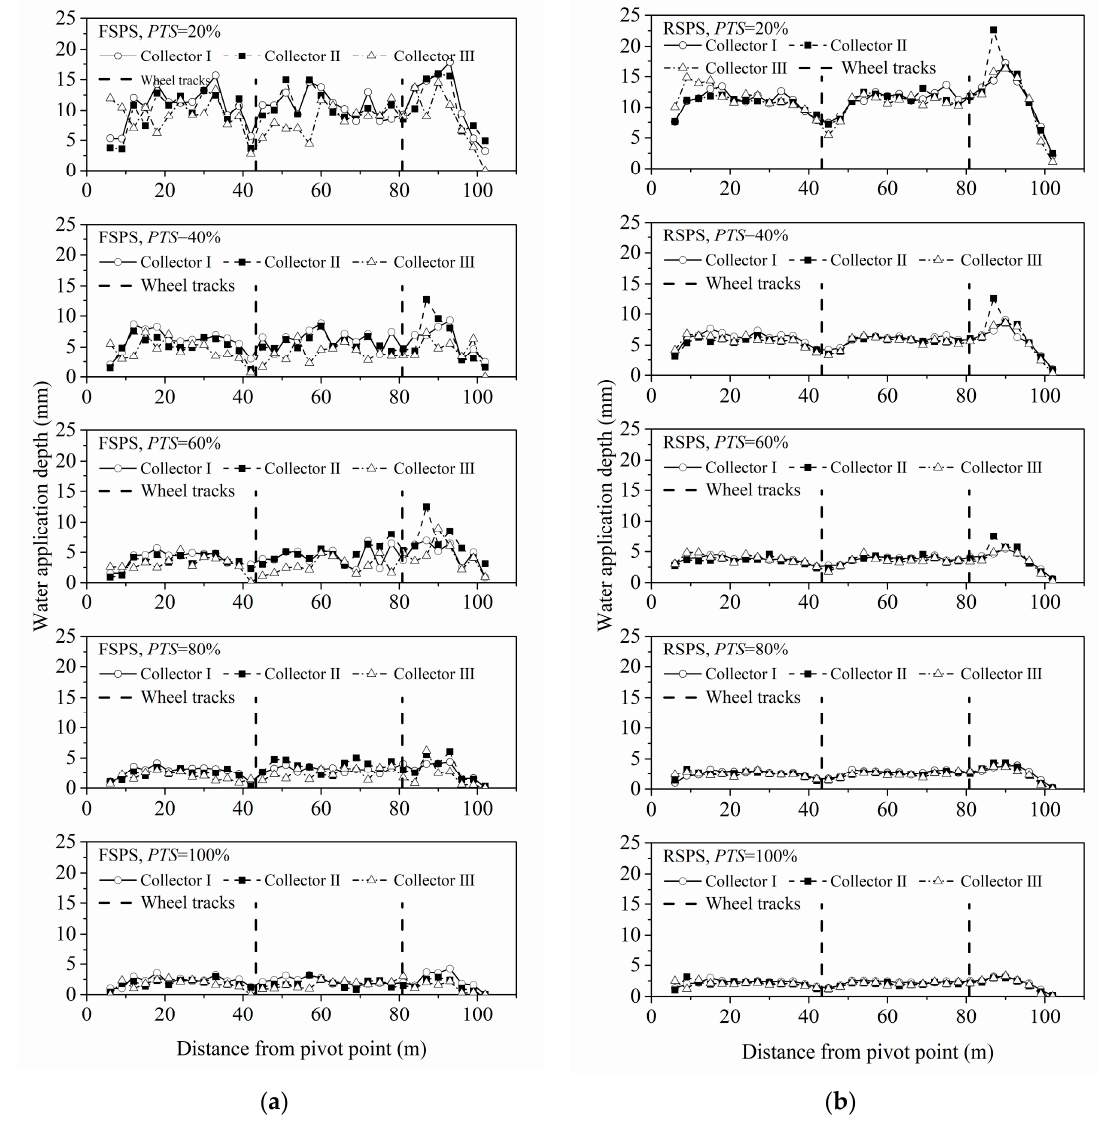
Figure 7. Water application depth versus distance from the pivot point for the three types of collectors: ( a ) FSPS, PTS = 20%–100%; ( b ) RSPS, PTS = 20%–100%. Table 4. Weighted average water application depths for the three types of collectors at the five travel speeds.